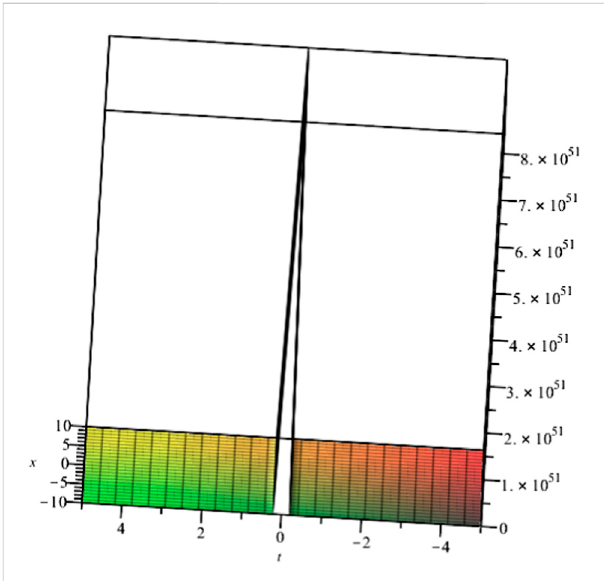
FIGURE 9 Solution pro fi le of Eq. 4.20 with α = γ = b 2 = b 3 = c 1 = 1, δ = 10.